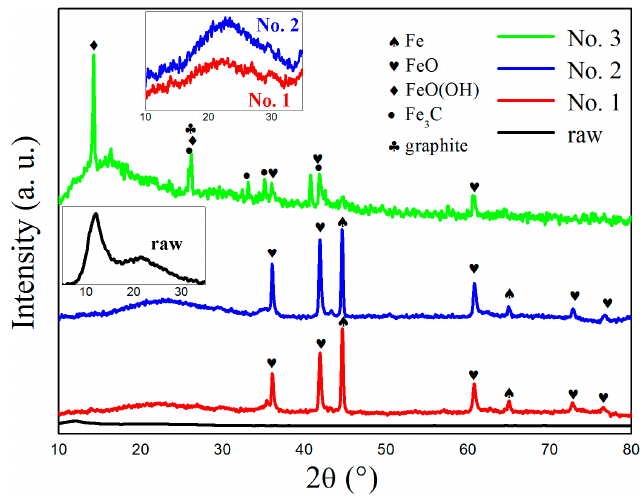
Figure 2. X-ray diffraction (XRD) patterns of raw GO and samples No. 1–3. The insets of Figure 2 show the weak and broad peaks appearing at 9°–30° in the XRD patterns of raw GO, samples No. 1 and 2. Table 2. Phase content of iron and iron compound of the recovered samples produced by pulsed iron wire discharge.